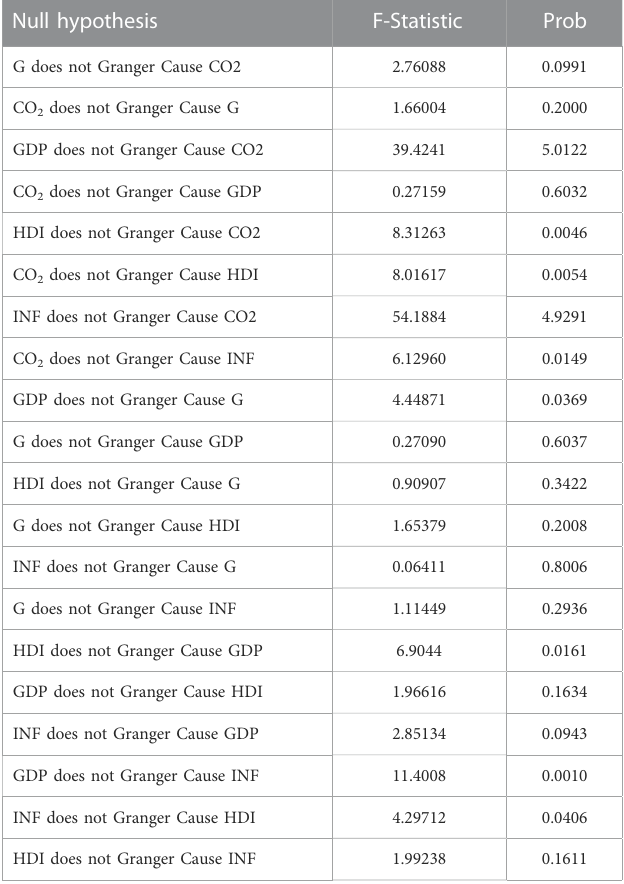
TABLE 4 Pairwise granger causality